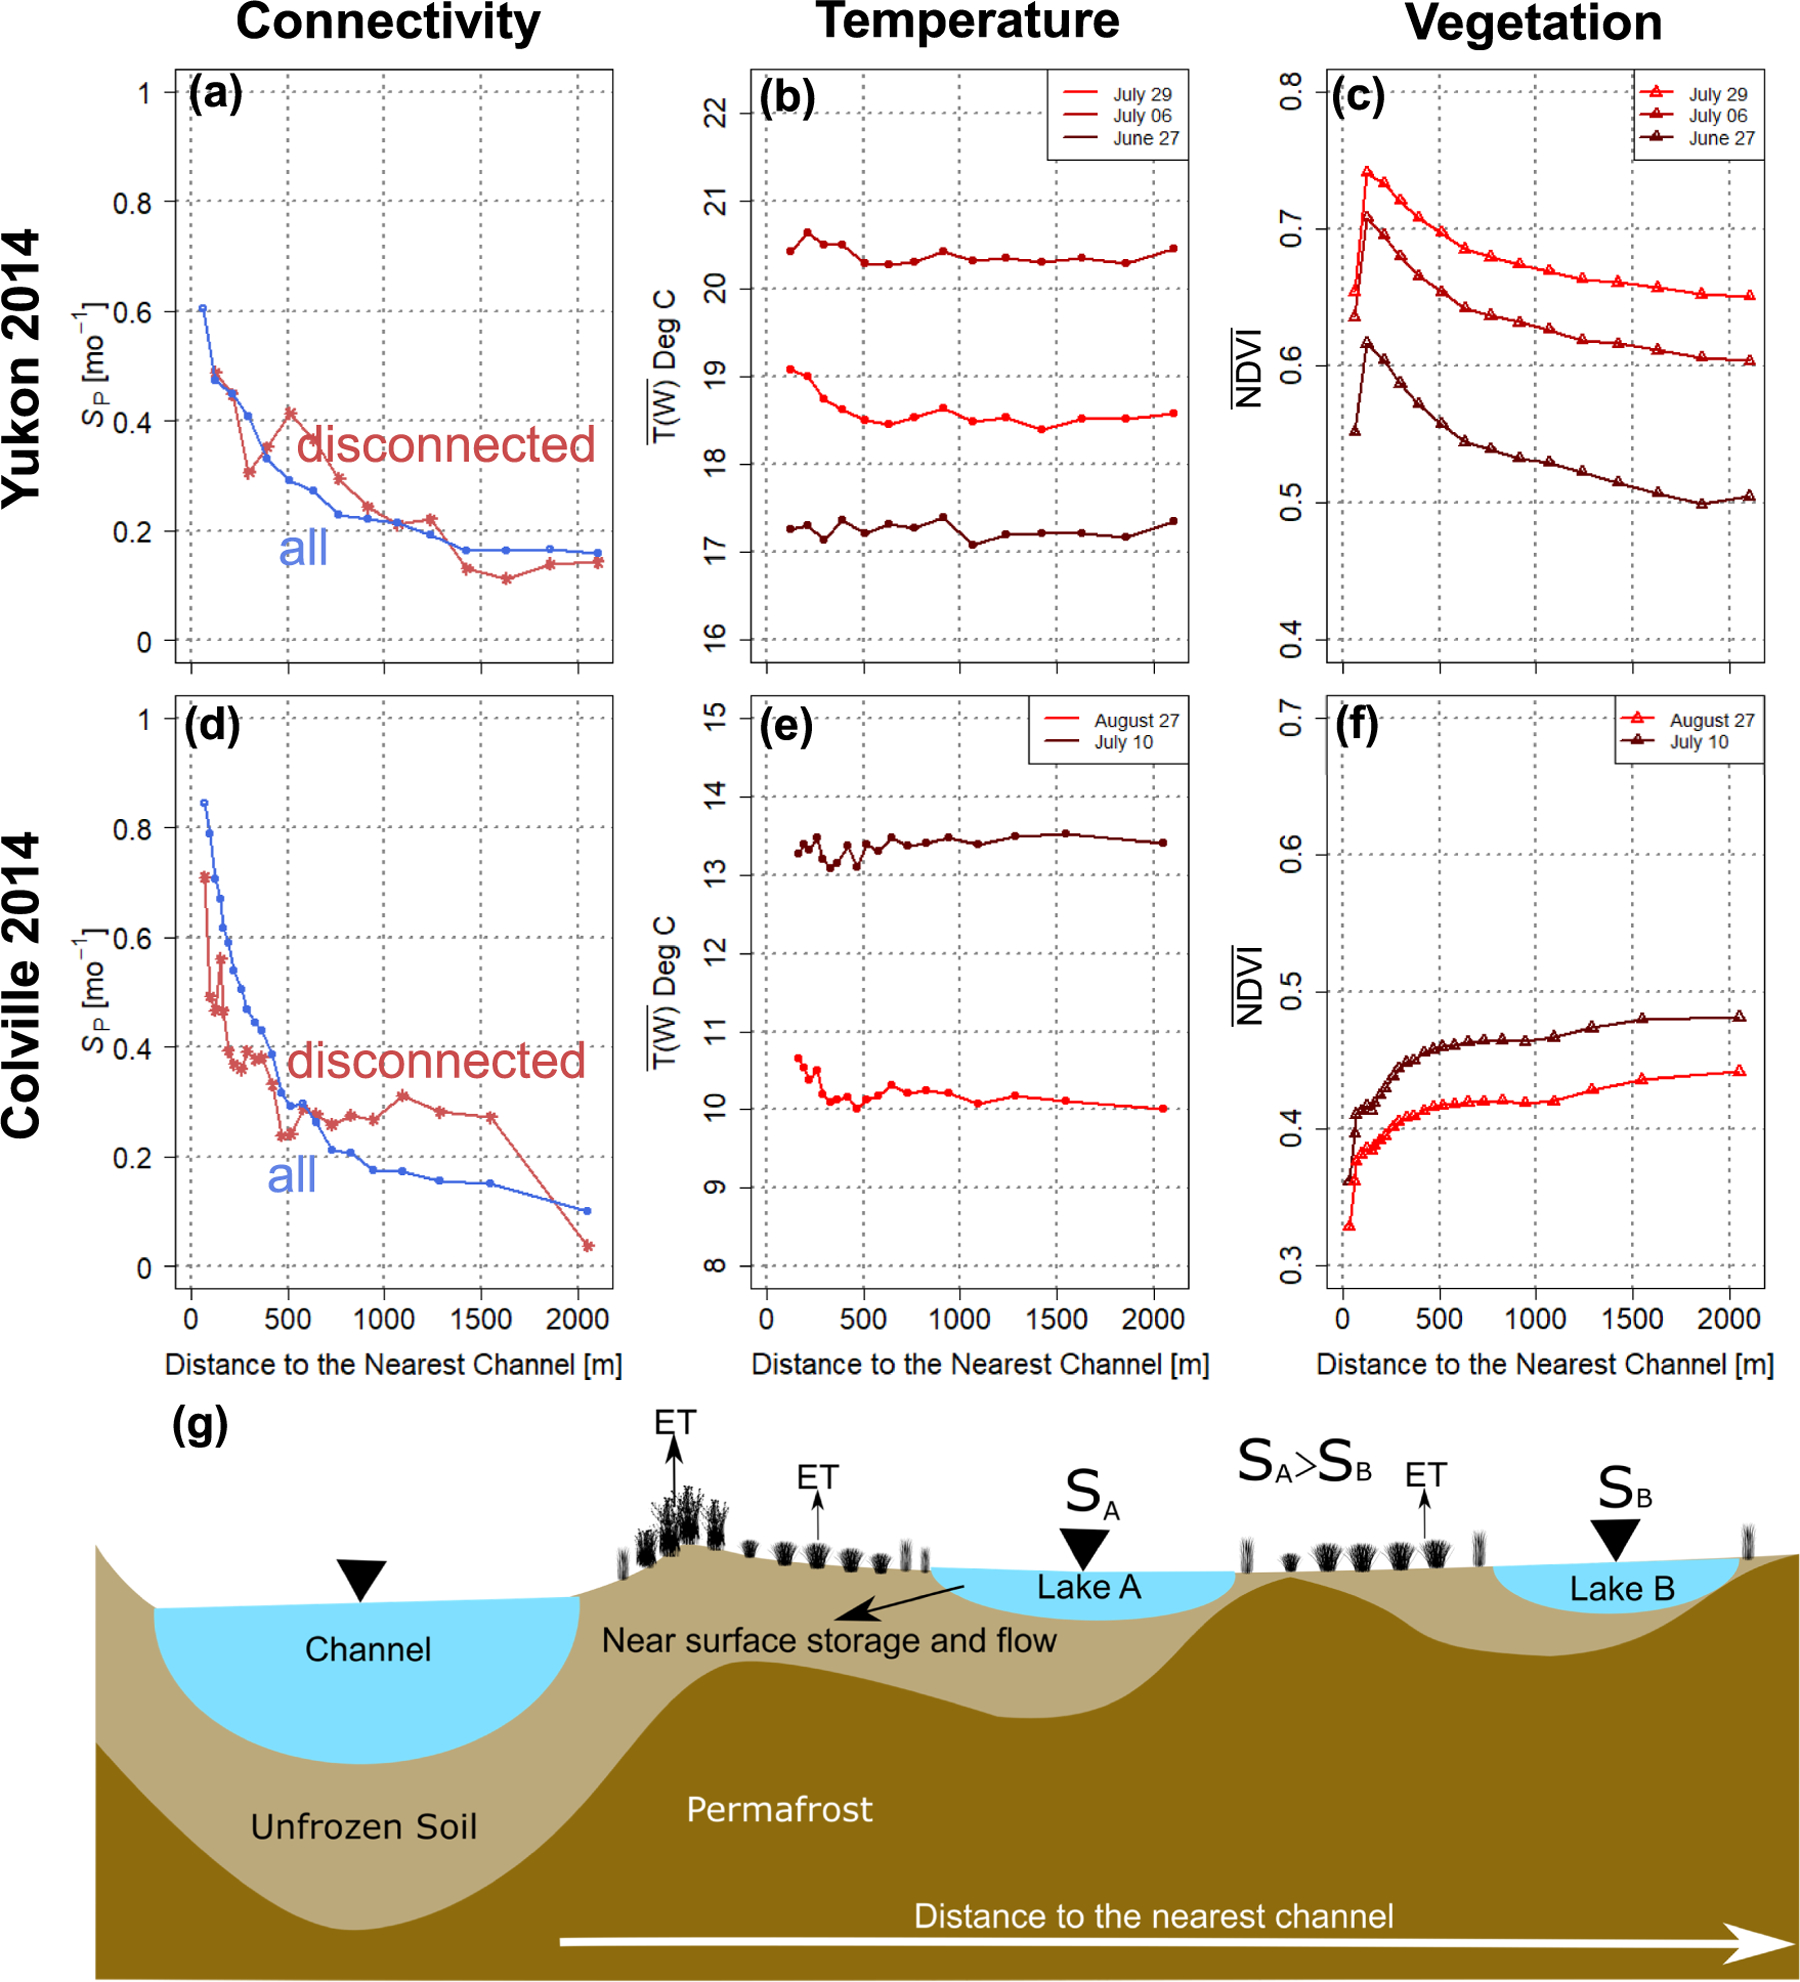
Higher resolution figure attached as PDF.Examining physical mechanisms for increased lake shrinkage closer to the delta channel network. (a, d) Comparison of the 2014 water area shrinkage rates of all lakes disconnected from the channel network as inferred from the Landsat images at 30-m resolution (same as in Figures 2a and 2b) and a subset of lakes disconnected from the channels as inferred from high resolution (0.6 m) to rule out that subpixel surface connectivity not seen in Landsat cannot explain the observed structured shrinkage patterns. (b, e) Average surface temperature of water pixels in internal perimeter IP2 (a proxy for lake depth) is independent of distance from the channel network indicating that lake depth is not the primary cause for the observed higher shrinkage rates closer to the channels. (c, f) Mean NDVI of June land pixels spikes and decreases on the Yukon (c), and steadily increases on the Colville indicating presence of barren sandbars next to the channels (f). (g) Schematic illustrating that the enhanced shrinkage, S, closer to the DCN is predominantly caused by increased near-surface storage and flow, a result of increased heat content near the channel, and modulated by higher evapotranspiration rates due to denser vegetation content on the Yukon.